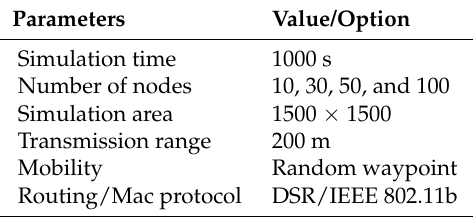
Table 1. Simulation parameters. DSR—dynamic source